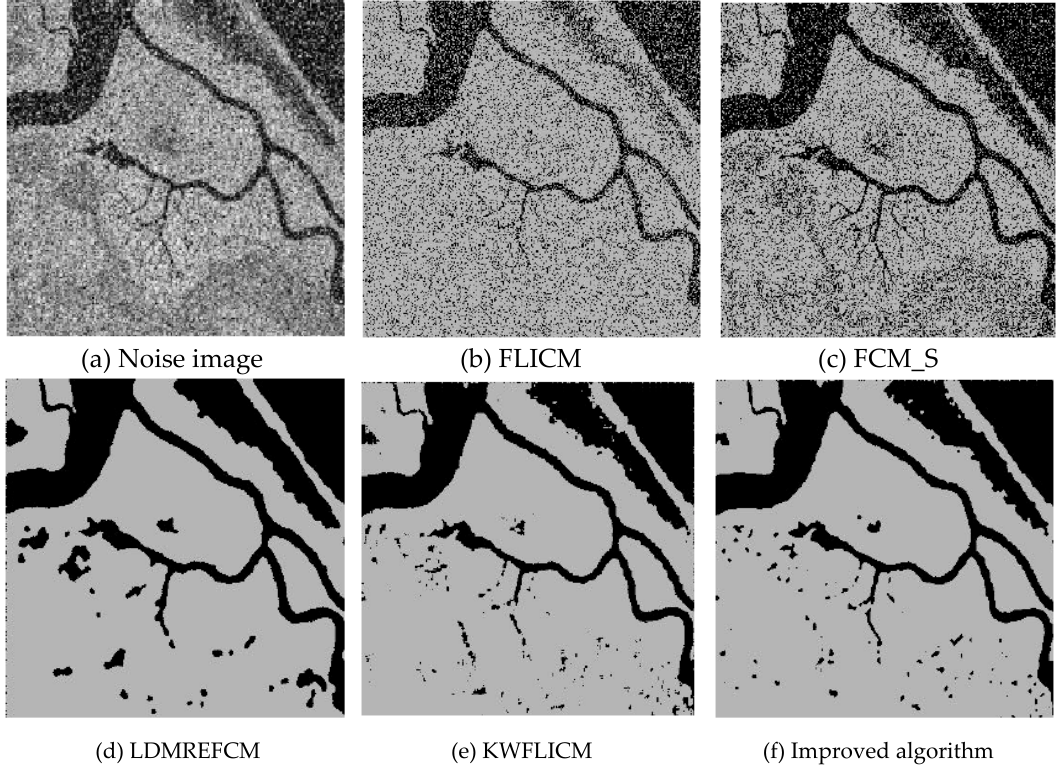
Figure 18. Interference of mixed noise on the river image ( a ) and the segmentation results ( b – f ).